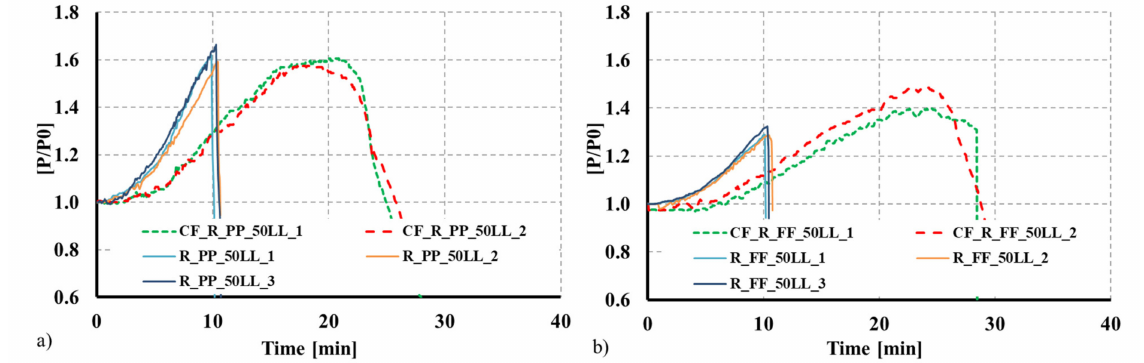
Figure 10. Comparison between bare steel CFS 2R columns and concrete-filled CFS 2R columns as a function of time. ( a ) Pinned columns. ( b ) Fixed